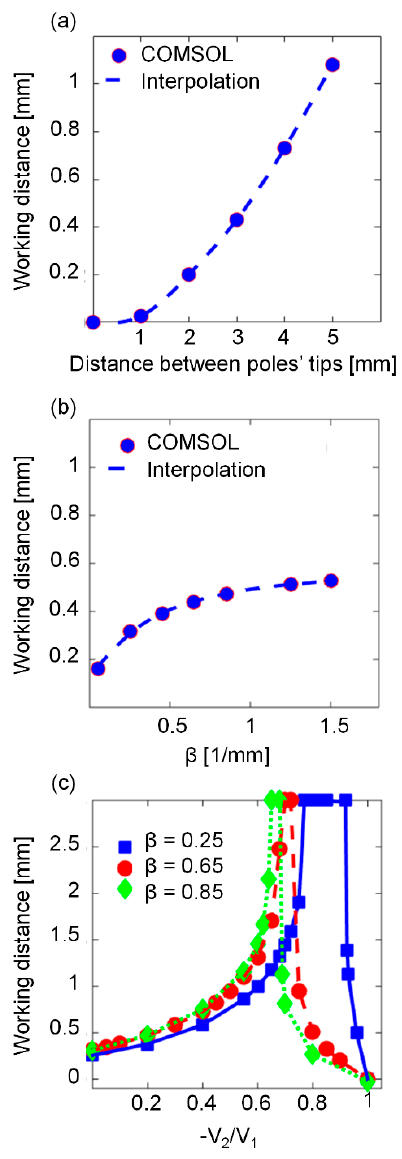
Figure 6. Characteristics of the working distance for a system of two electromagnets with parabolic pole tips that are positioned opposite each other. ( a ) The working distance as a function of the distance between the pole tips ( 𝛽 = 0.65 ). ( b ) The working distance as a function of the parabolic coefficient, 𝛽 (the distance between the pole tips is 3 mm). ( c ) The working distance as a function of the ratio between the voltages of the electromagnets (all 𝛽 units are in [1/mm], and the distance between the pole tips is 3 mm).